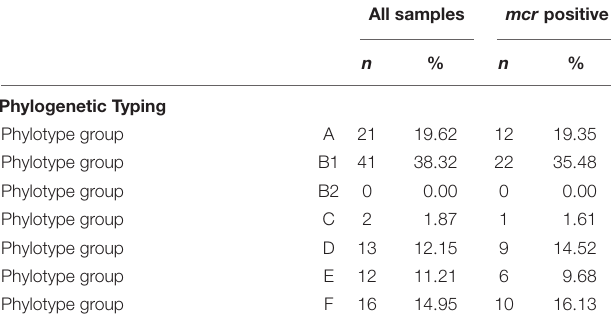
TABLE 1 | Prevalence of genes tested in all samples and in mcr positive samples. All samples mcr